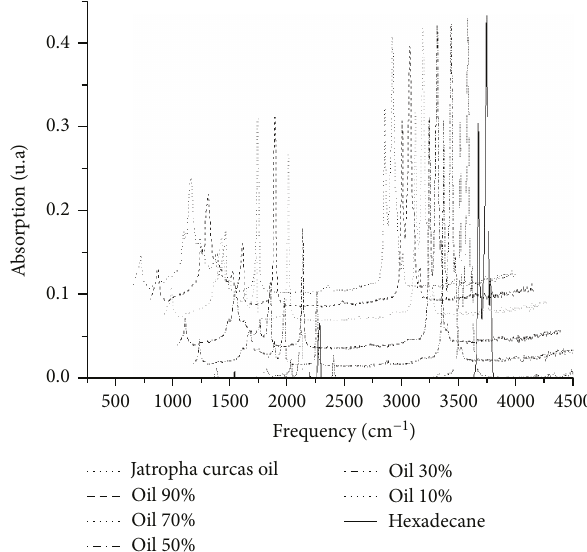
Figure 1: FTIR spectra of calibration curve of Jatropha curcas oil with hexadecane [12].